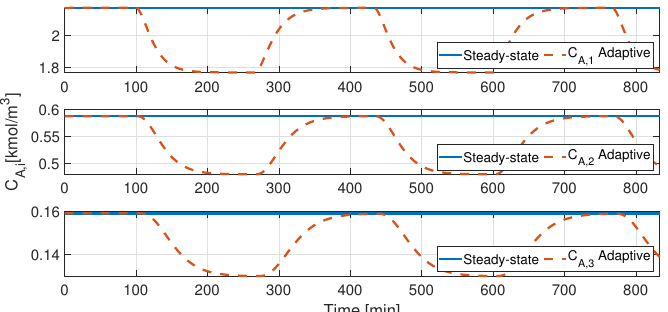
Figure 9. Performance of adaptive controller under an abrupt abrupt change in temperature in reactor R 1 —Concentration C A , i evolution.